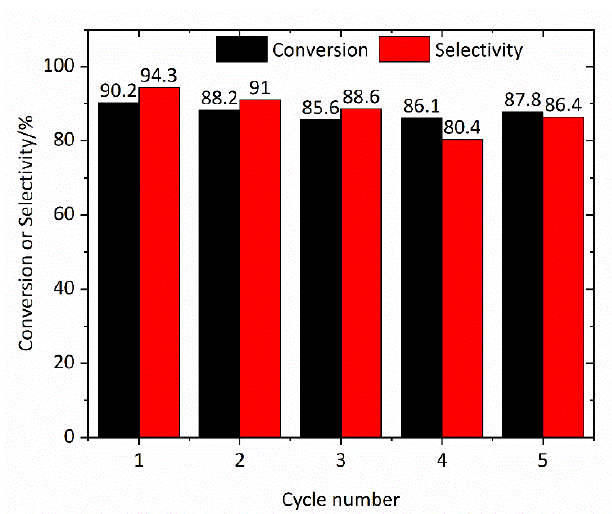
Figure 8. Recycle experiments of styrene epoxidation with Mn 0.1 Cu 0.9 -MOF.